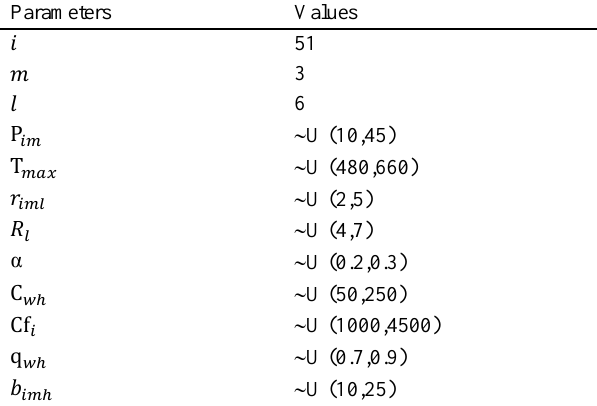
Table 9. Data sets of the real case